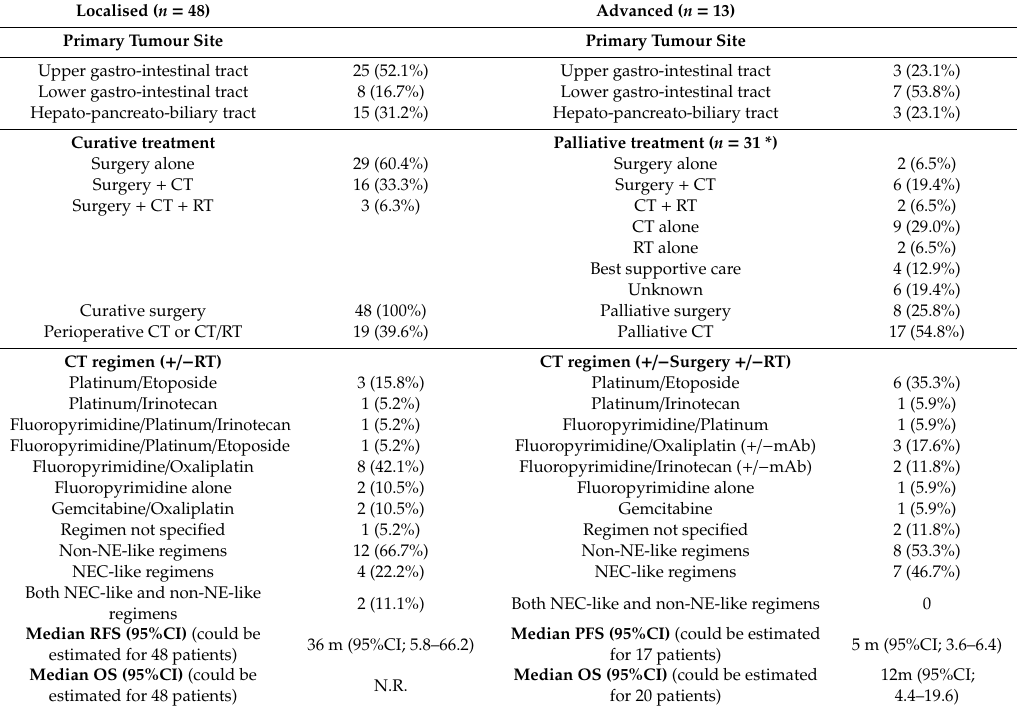
Table 2. Treatment modalities and survival outcomes of patients with a diagnosis of mixed neuroendocrine non-neuroendocrine neoplasm in case reports according to disease stage.